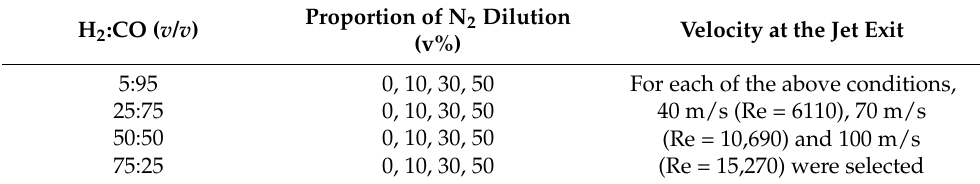
Table 1. Operation conditions of syngas/air premixed jet flame.